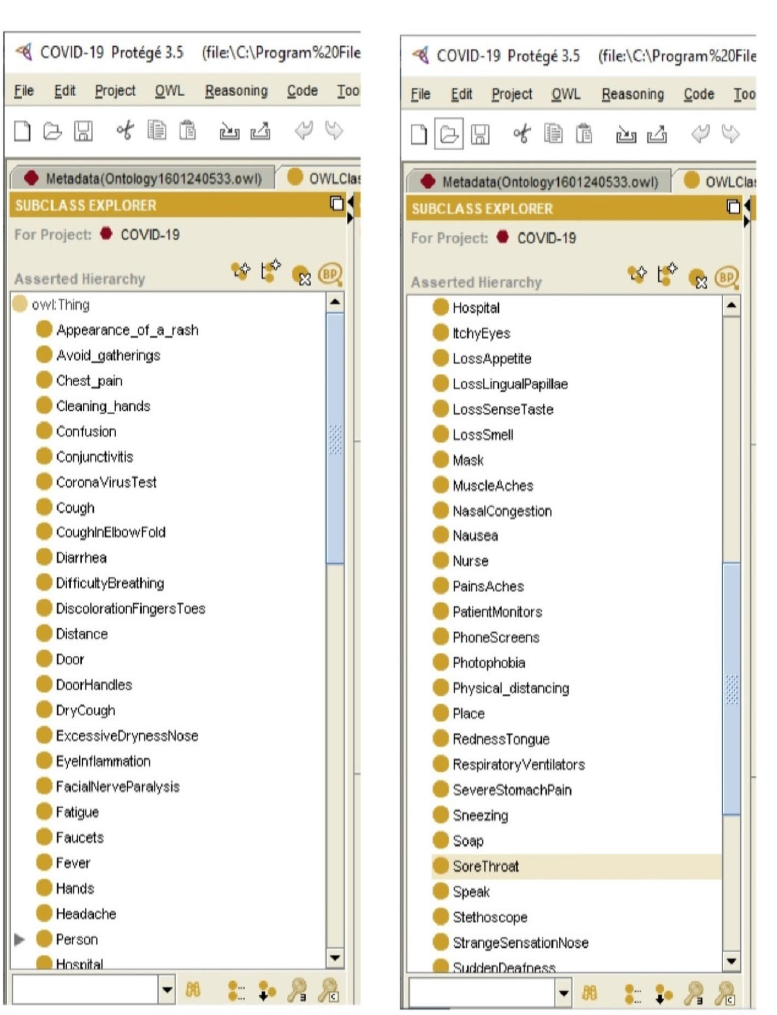
Figure 2. Hierarchy of classes in “Protégé” software.